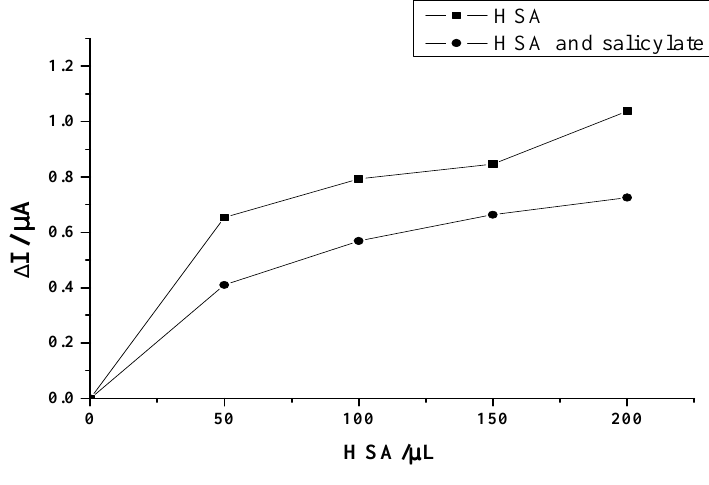
Figure 8. Plot of the decrease of the camptothecin peak current versus the addition of different volume of mixture of HSA and salicylate sodium (The volume ratio of HSA to salicylate is 1:1). The concentration of salicylate sodium: 1.0×10 -6 M. Others same as in Figure